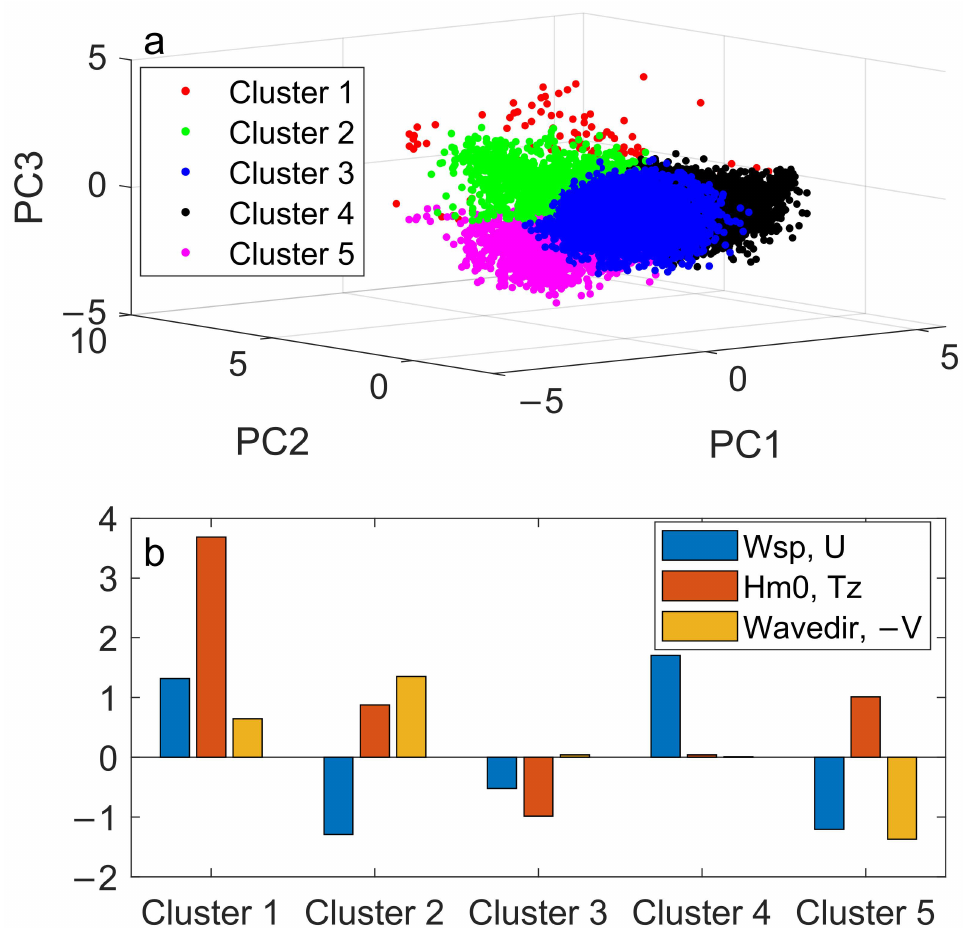
Figure 4. Scatter diagram of the classification of the first three PCs of wind-wave dataset ( a ) and the standardized characteristics of each cluster ( b